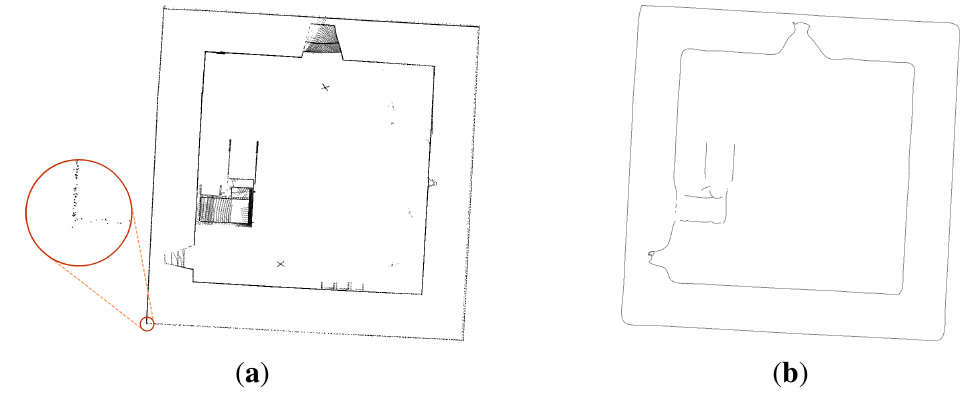
Figure 8. First part of the slicing workflow (3D data): the magnified portion shows the uneven density of the raw data. ( a ) Points within the ∆ z increment; ( b ) final processed slice of